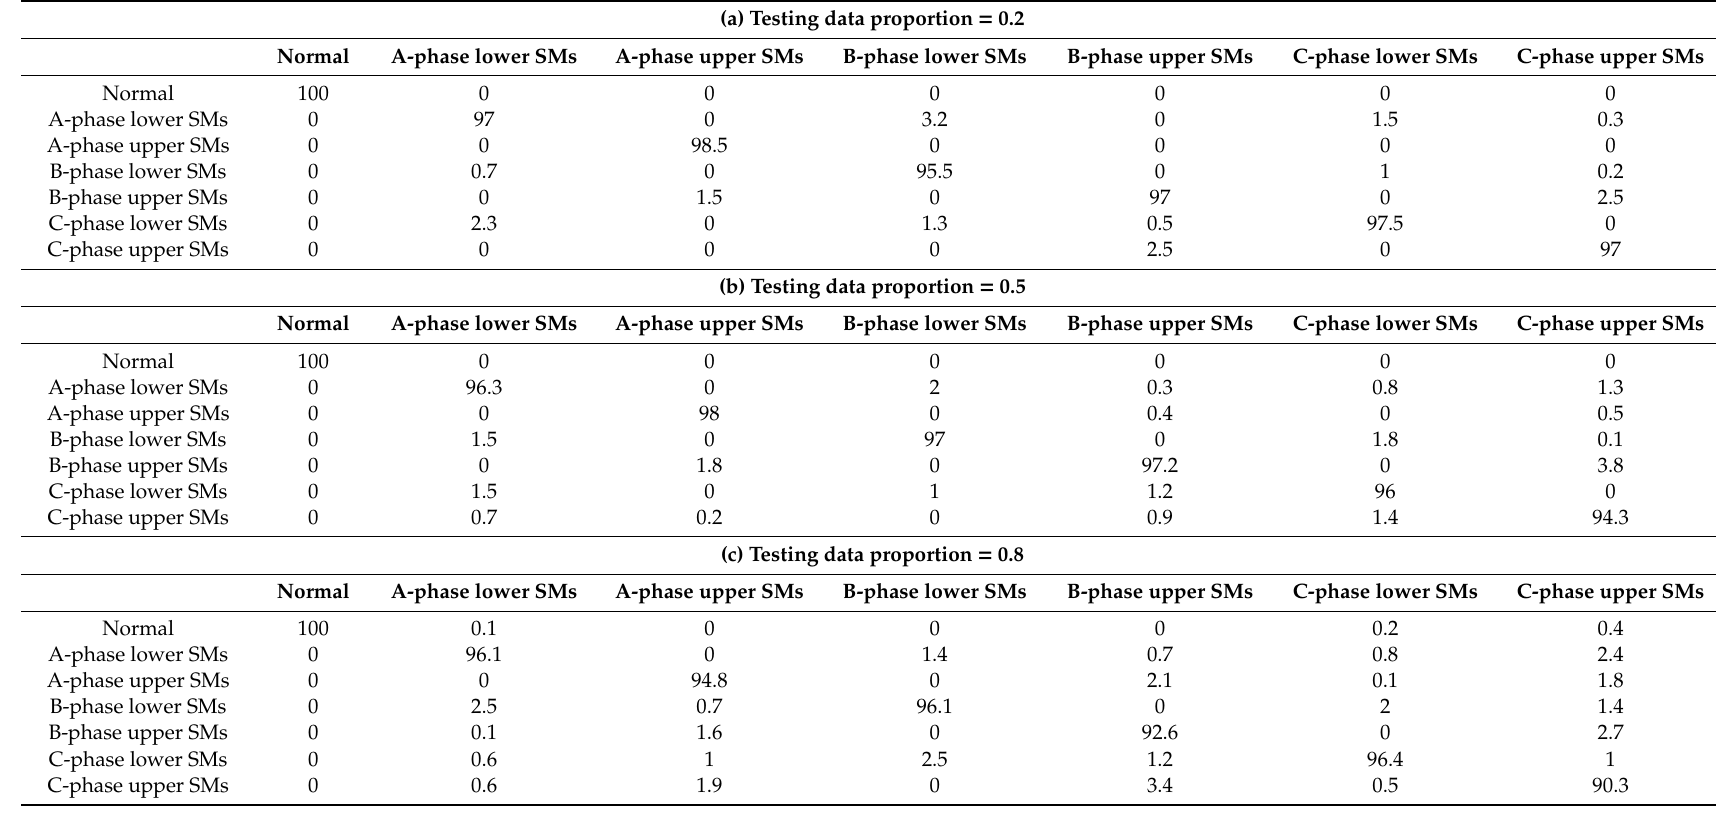
Table 6. Sample confusion matrix of the classification results of AE-based DNN.